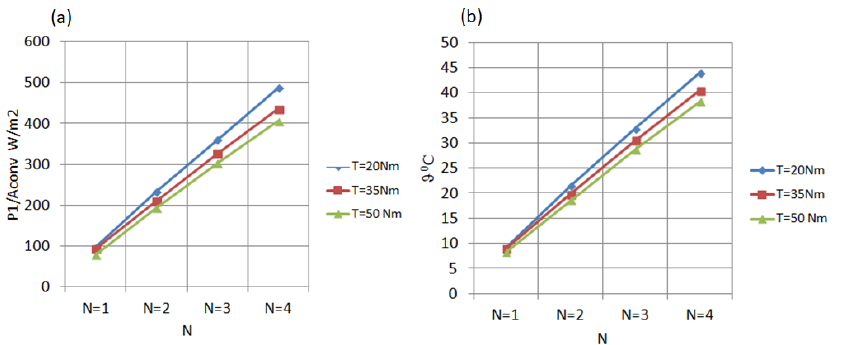
Figure 14. Comparison of function courses: ( a ) the course of ratio ∆ P Cu / A conv vs. the number of discs for T c = 20, 35 and 50 Nm; ( b ) maximum temperature ϑ hmax vs. number of discs N for T c = 20, 35 and 50